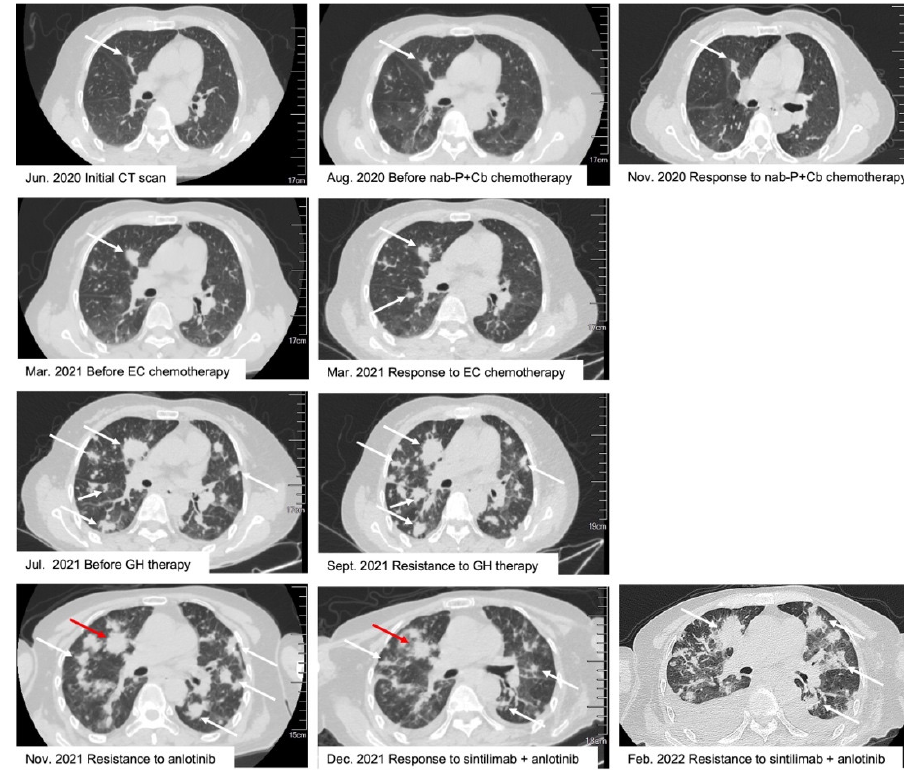
Figure 2. Computed tomography scan images of the patient’s clinical course. Abbreviation: nab-P: nab-paclitaxel; Cb: carboplatin; EC: epirubicin/cyclophosphamide; GH: gemcitabine/trastuzumab. (The red arrow shows the location of the target lesion. The white arrow shows the location of the non-target lesion.)